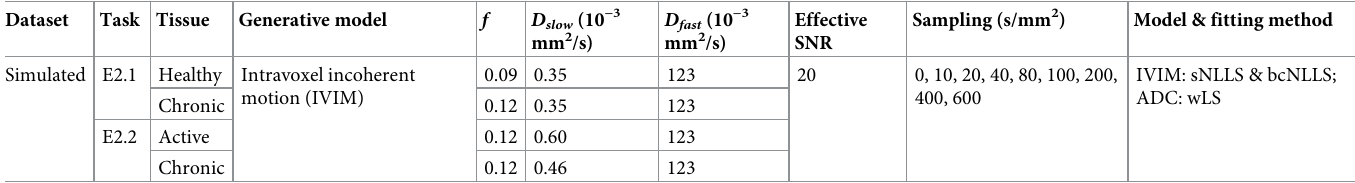
Table 2. Computational pipeline settings for E2. Synthetic signals were generated from the IVIM model. Both IVIM and ADC parameters were estimated from IVIM- synthesised data. Dataset Task